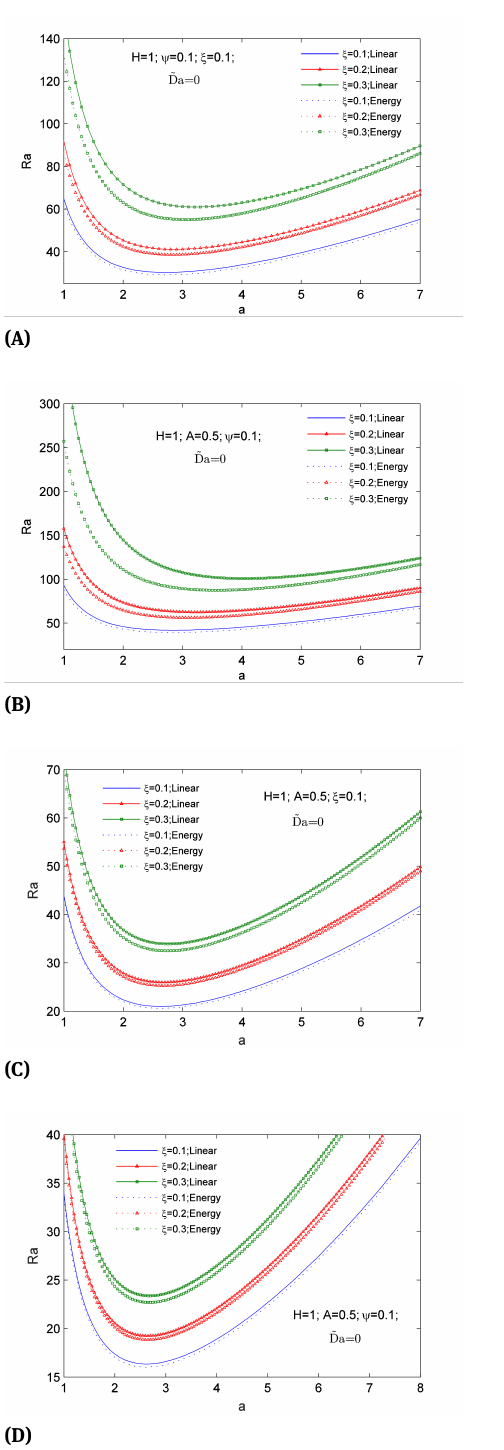
Fig. 5: Neutral stability curves for case A, B, C and D at different values of H and fixed values of ψ , ξ , ˜ Da ,